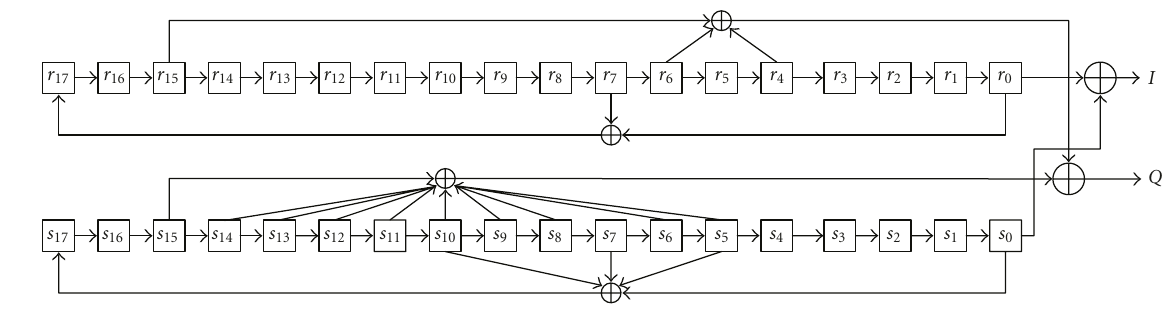
Figure 3: Scrambling sequence for